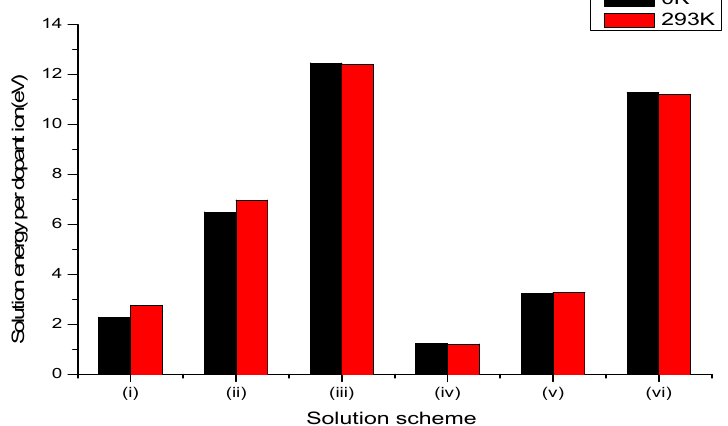
Figure 8. Bar chart of solution energies vs. solution schemes for hexavalent dopant (Mo 6 + ) at the Li and Nb sites, considering the first neighbours in relation to the c axis.